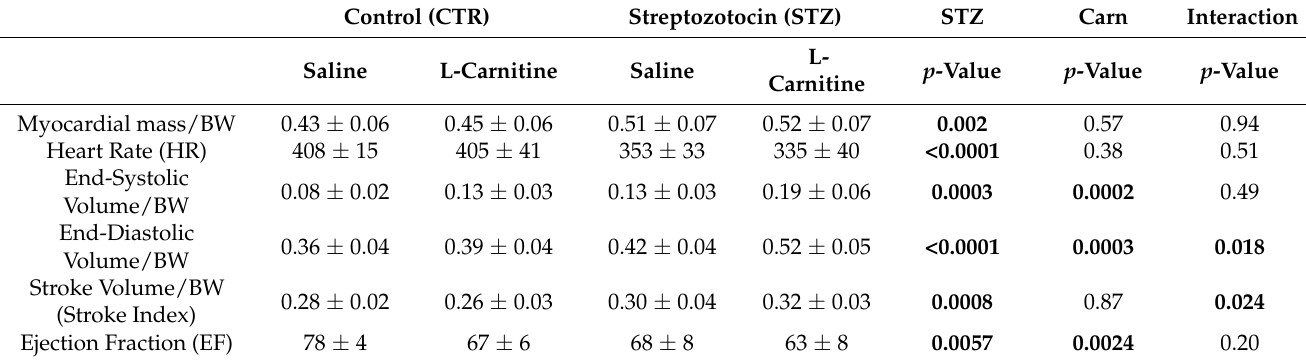
Heart Rate (HR) 408 ±